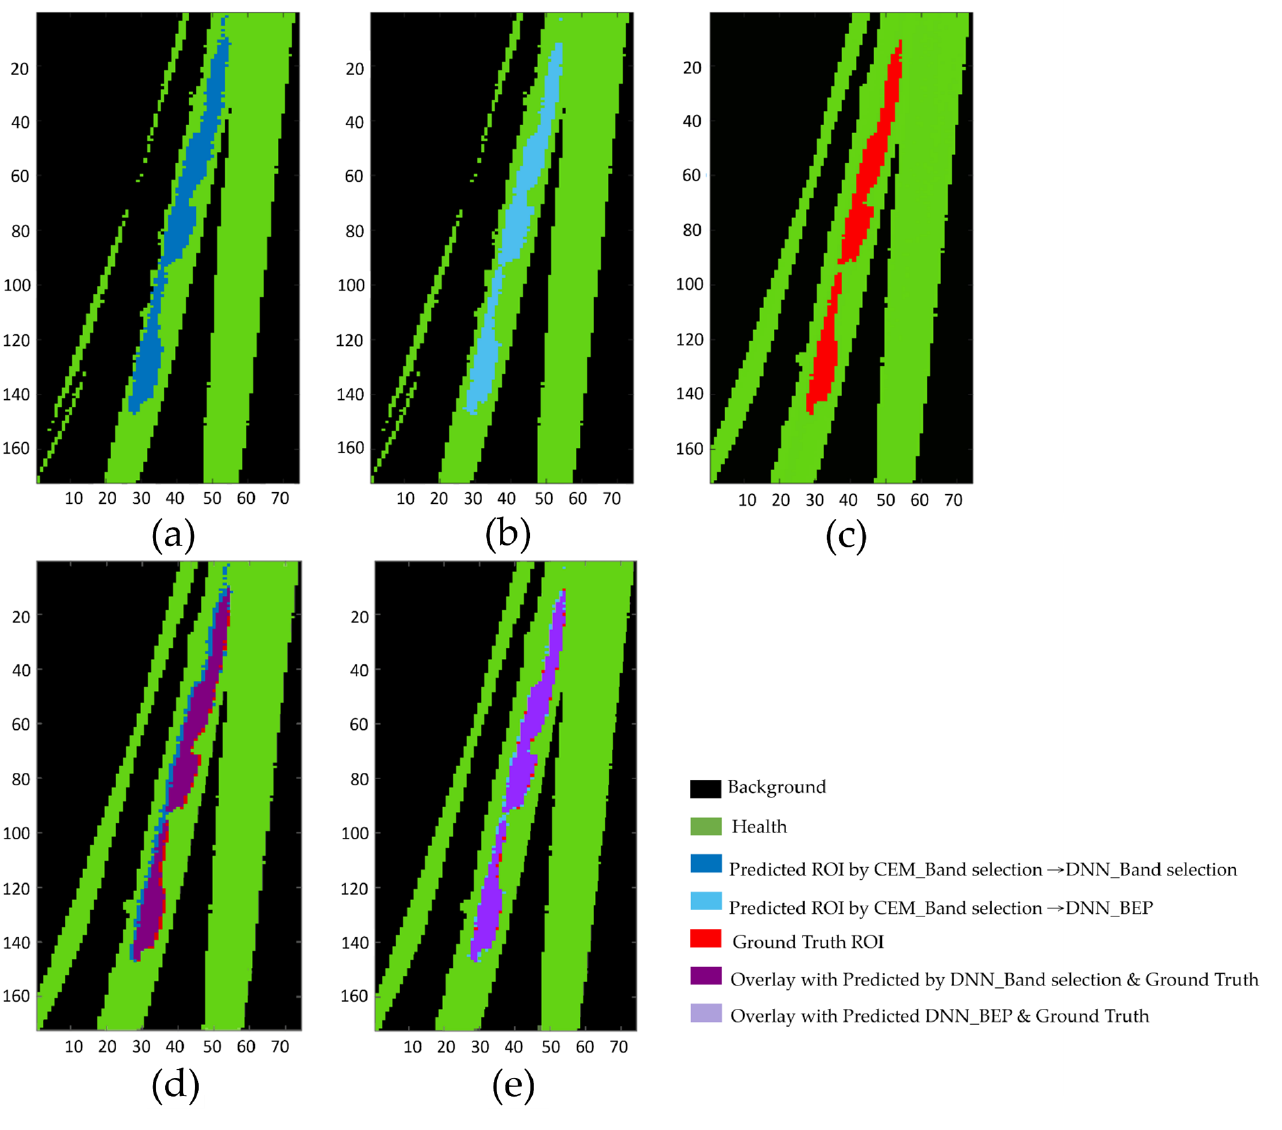
Figure 11. Overlaid images of the predicted ROI with the ground-truth ROI for evaluating the performance of DNN classification. ( a ) Predicted ROI with CEM_band selection → DNN_band selection, ( b ) predicted ROI with CEM_band selection → DNN_BEP, ( c ) Ground Truth, ( d ) Overlay with ( a , c , e ) Overlay with ( b , c